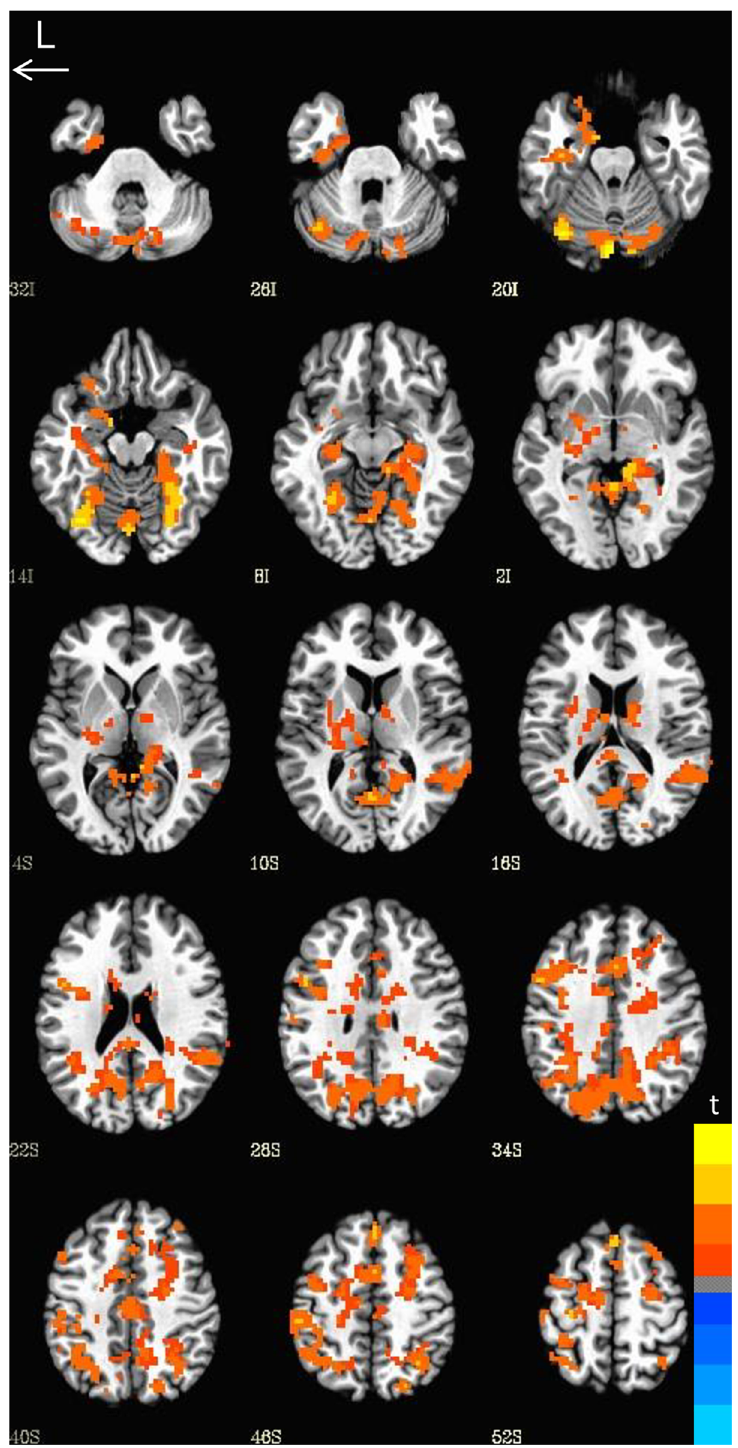
Fig 5. Neural activation by group. Comparisons of the Val/Val homozygotes and Met carriers. The Met carriers showed greater activation relative to the Val/Val homozygotes.